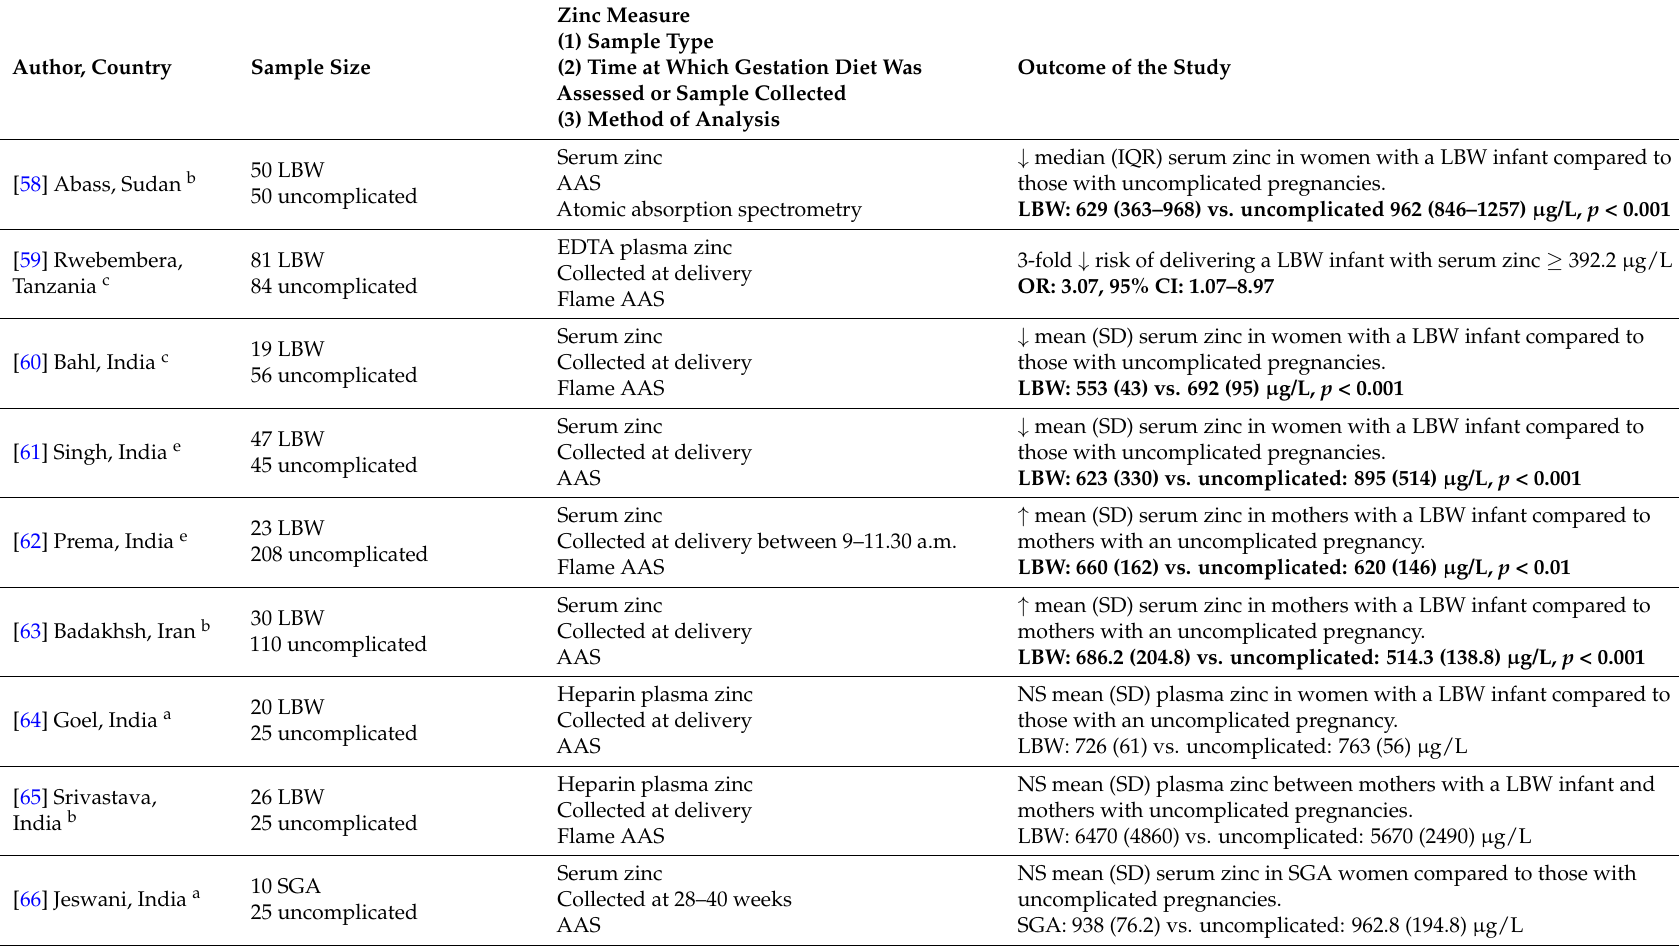
↓ median (IQR) serum zinc in women with a LBW infant compared to those with uncomplicated